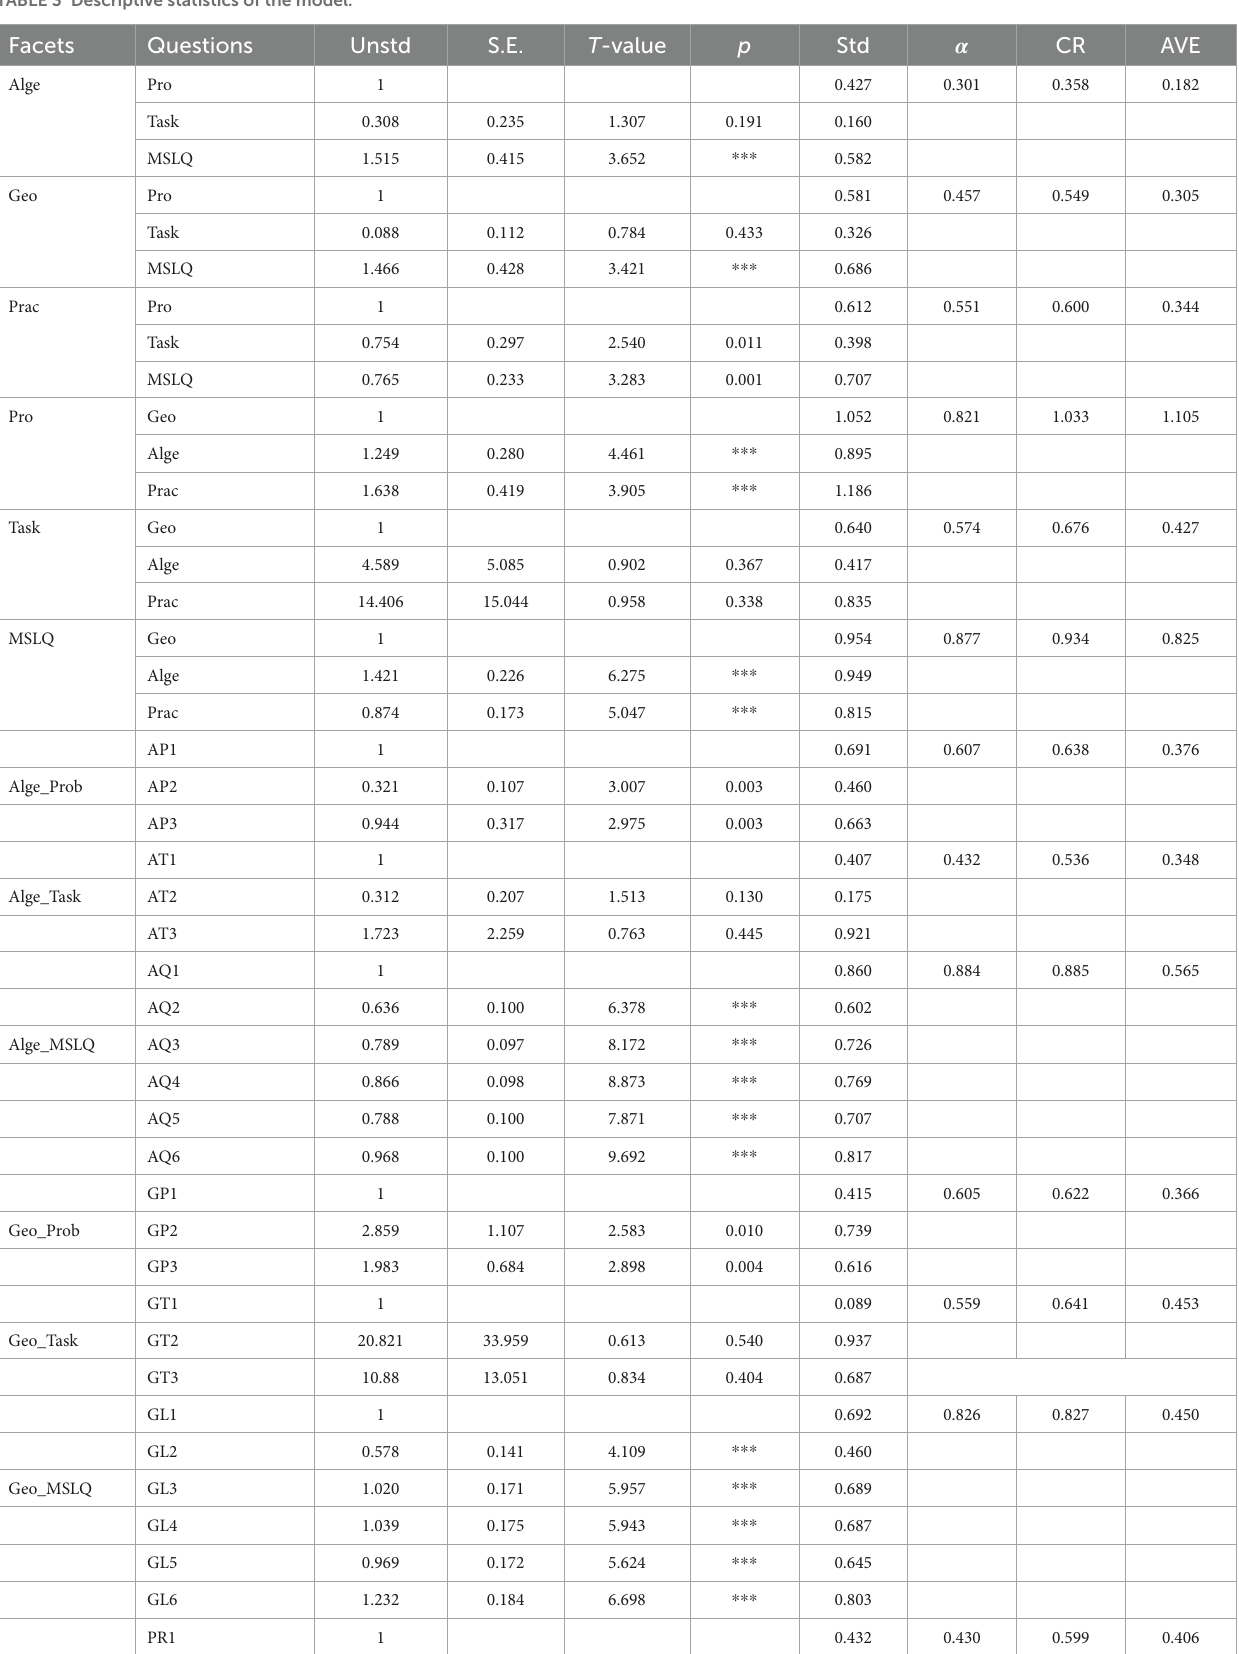
TABLE 3 Descriptive statistics of the model.